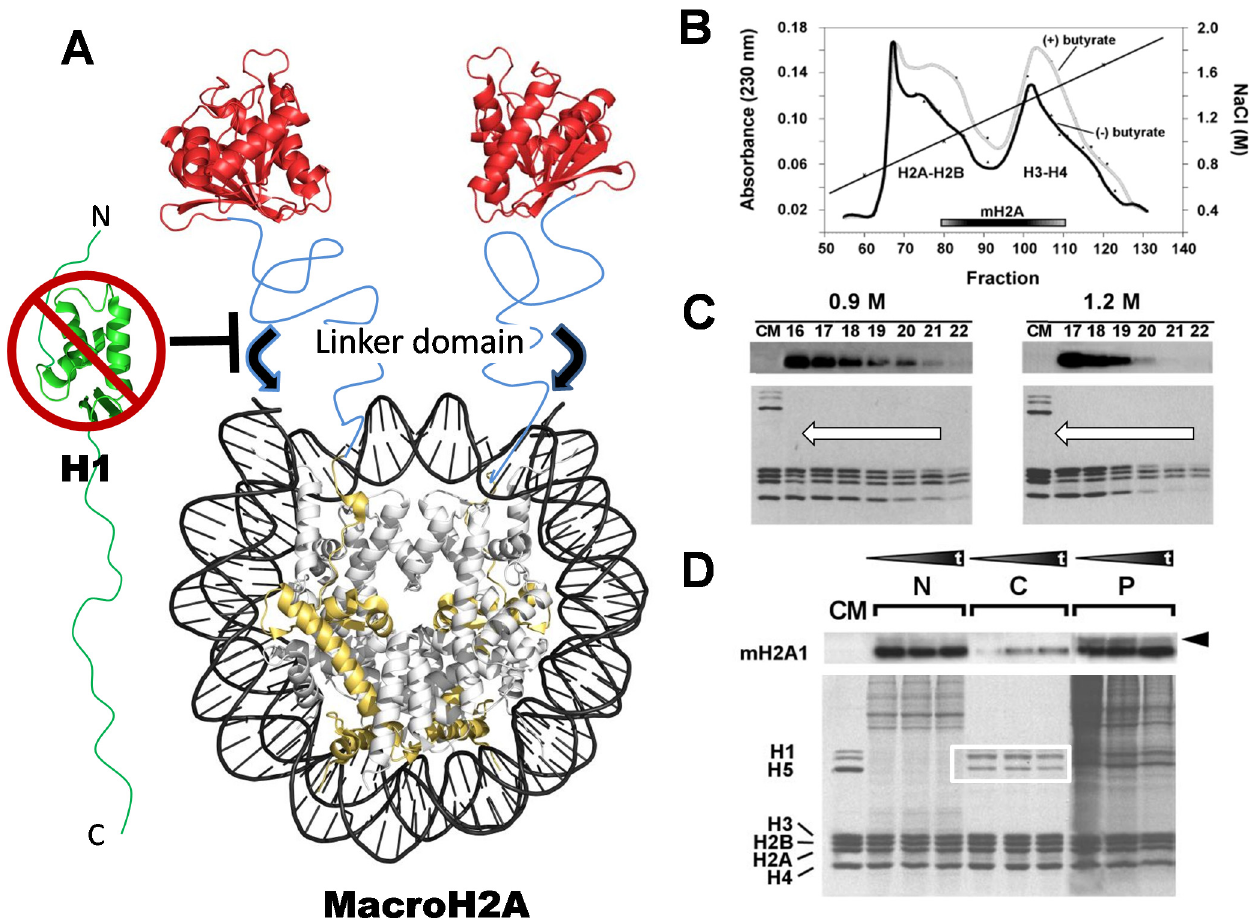
Figure 4. ( A ) Schematic representation of the macroH2A-containing nucleosome, based on the crystallographic structure of the N-terminal histone domain of macroH2A (gold) and on the crystallographic structure of the C-terminus of the macro domain (red) [111]. The tertiary structure of the linker domain region (depicted in blue) is not known, but it likely corresponds to an intrinsically disordered domain. The black arrows indicate the additional protection of DNA (approximately 10 bp at the entry and exit site of the DNA into the NCP by this linker region [112]). The inability of histone H1 to bind to the macroH2A-containing nucleosome (see ( D )) is indicated; ( B ) Hydroxyapatite chromatography salt (NaCl) elution profiles of macroH2A, from chromatin extracts obtained from HeLa cells treated with or without sodium butyrate (to enhance global levels of histone acetylation). The elution of the H2A–H2B dimers, the H3-H4 tetramers, and also that of macroH2A, are indicated [113]; ( C ) MacroH2A western blot analysis of fractions (numbers) obtained from nucleosomes run on (5%–20%) sucrose gradients in the presence of 0.9 and 1.2 M NaCl. The SDS-PAGE analysis of the fractions is shown underneath. The arrows indicate the direction of the sedimentation. CM is chicken erythrocyte histone standard[110]; ( D ) MacroH2A western and SDS-PAGE analysis of chicken liver chromatin digested at increasing times, with micrococcal nuclease (black triangles). The digested chromatin thus obtained was fractionated according to a method initially described by Ada Olins et al. [114], which allows its separation into histone H1 depleted (N), histone H1-containing (white square) (C), and an insoluble (P)